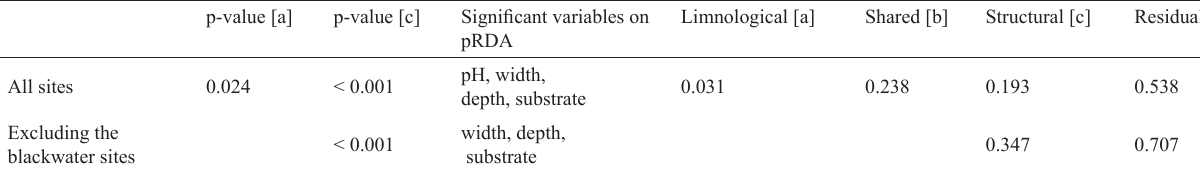
Table 3. Results of pRDA and variance partitioning for all sites and excluding blackwater streams. Negative fractions were not